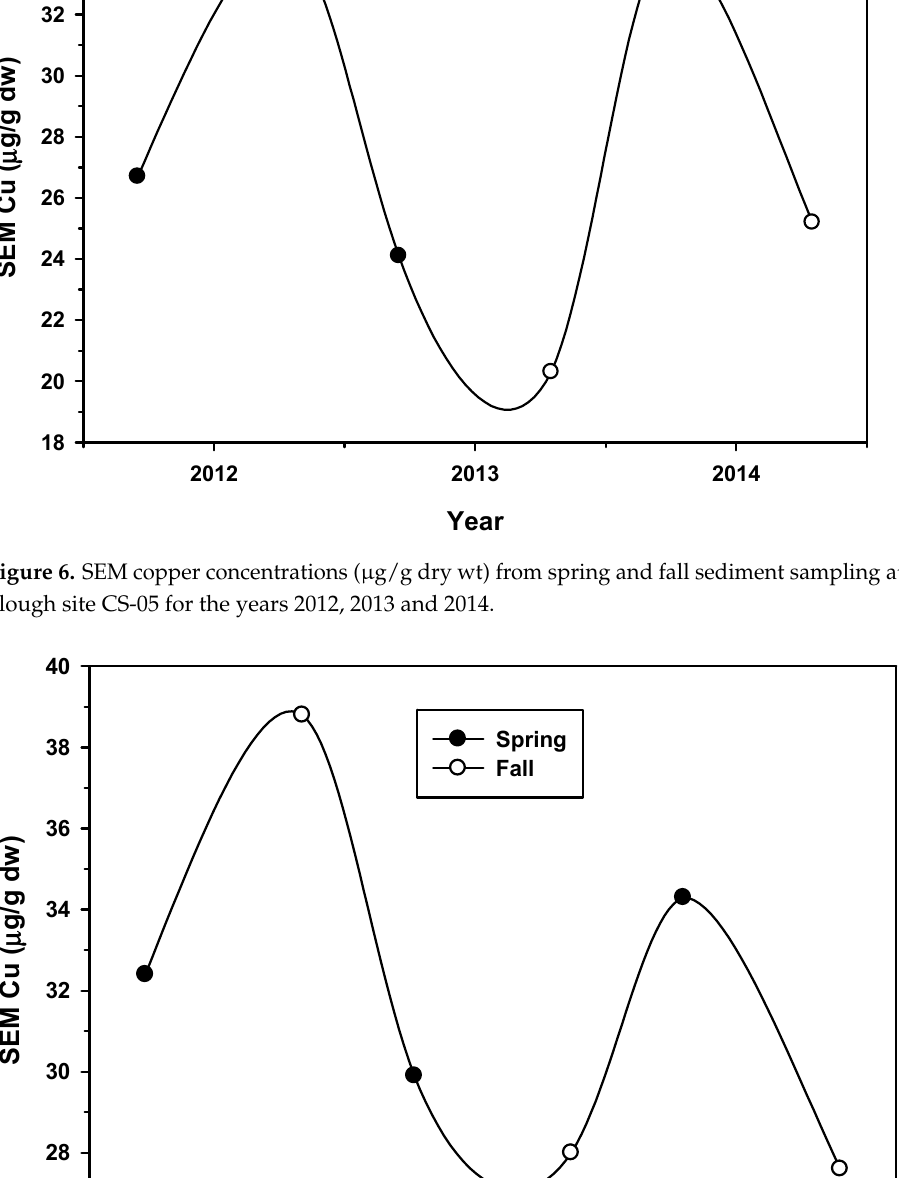
Figure 5. SEM copper concentrations (µg/g dry wt) from spring and fall sediment sampling at Cache Slough site CS-04 for the years 2012, 2013 and 2014.